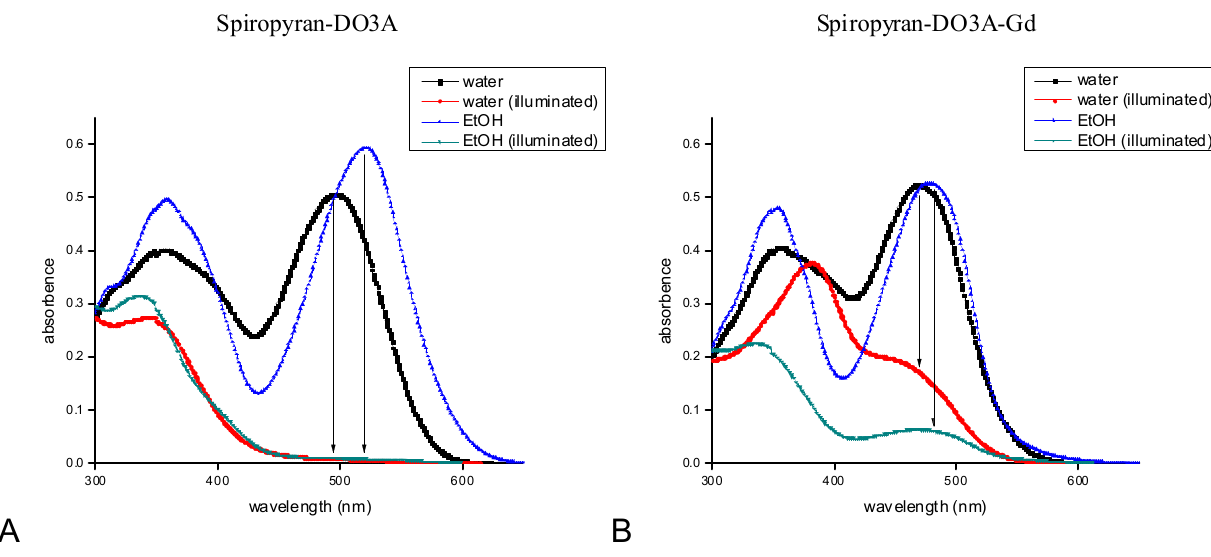
Figure 1. Spectroscopic characteristics of spiropyran-DO3A complexed and non-complexed with Gd(III): Absorption of water and ethanol solutions of spiropyran-DO3A were spectroscopically analyzed ( A ). Illumination of the solutions leads to a decrease in absorption and a shift of the actinic band in the range between 350 nm and 400 nm. A shift in the peak absorption wavelength of spiropyran-DO3A complexed with Gd(III) ions in ethanol and water could be detected ( B ). Illumination of spiropyran-DO3A-Gd in water leads to a decreased MC to SP conversion compared with the ethanol solution.